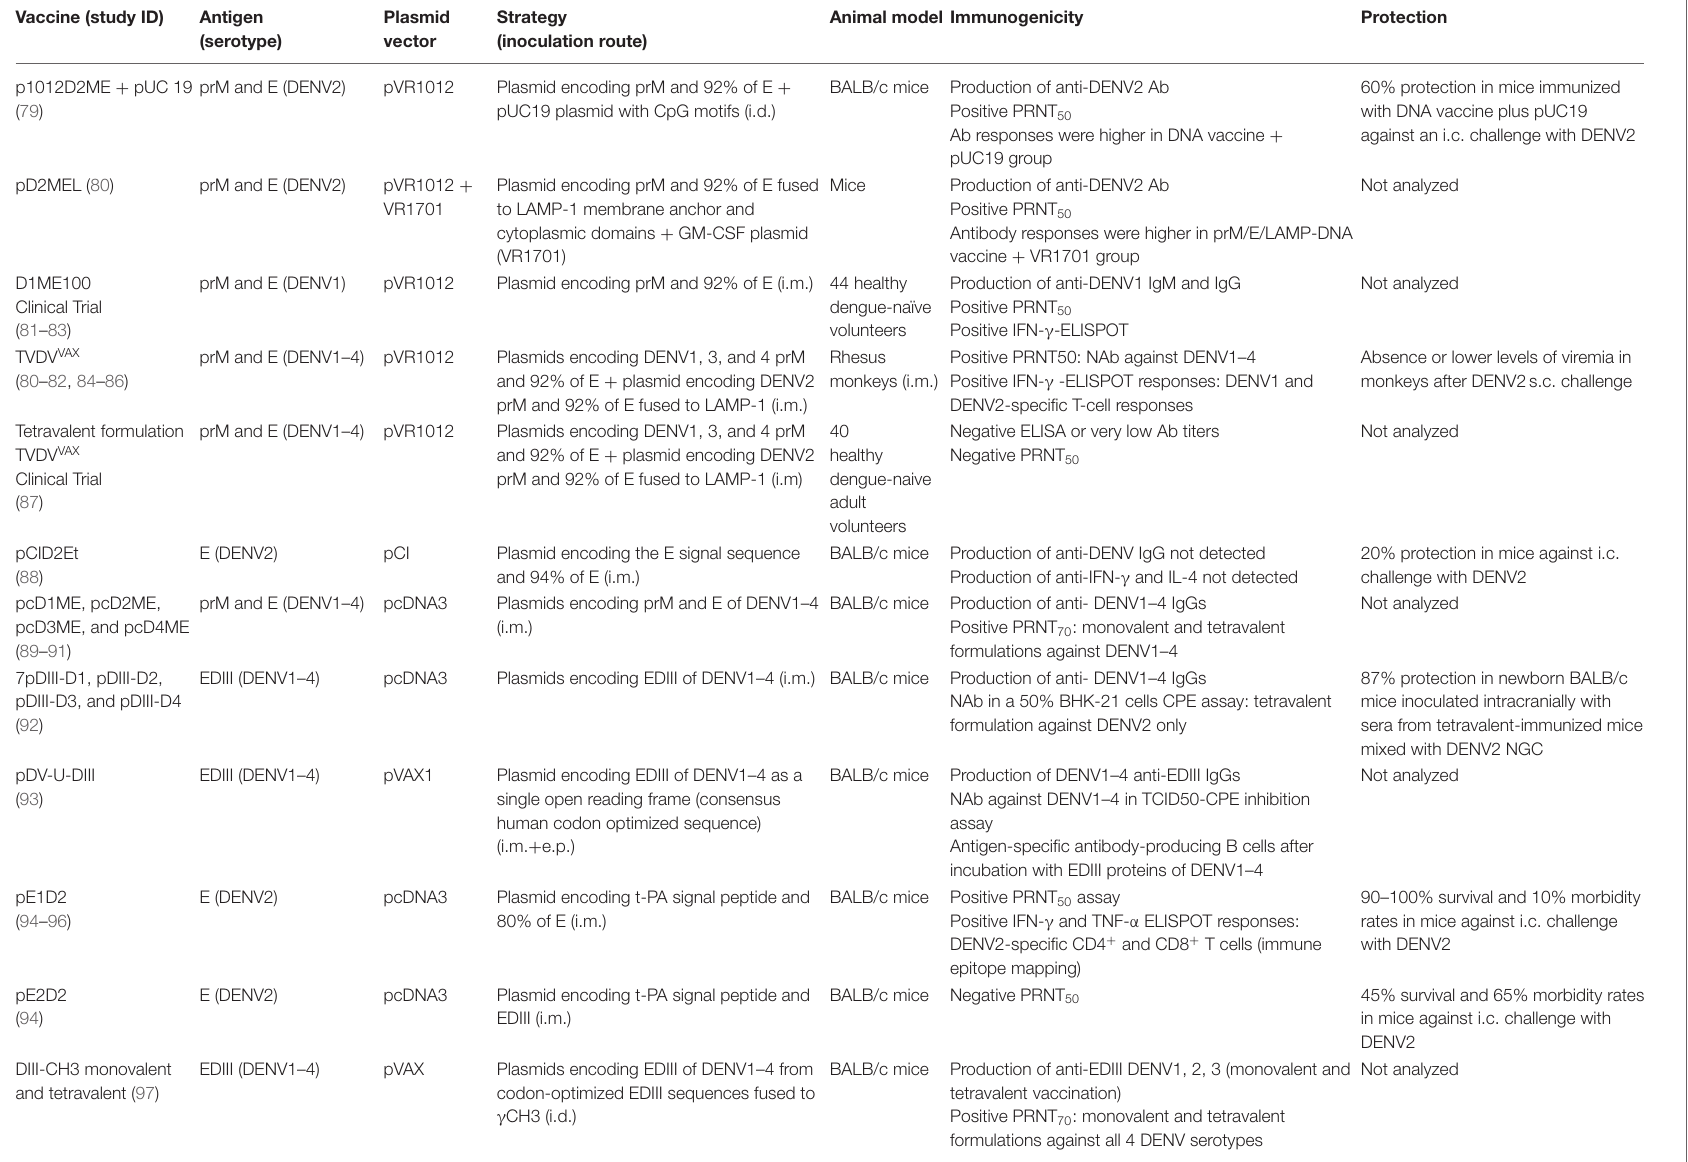
TABLE 1 | DNA vaccines based on dengue structural